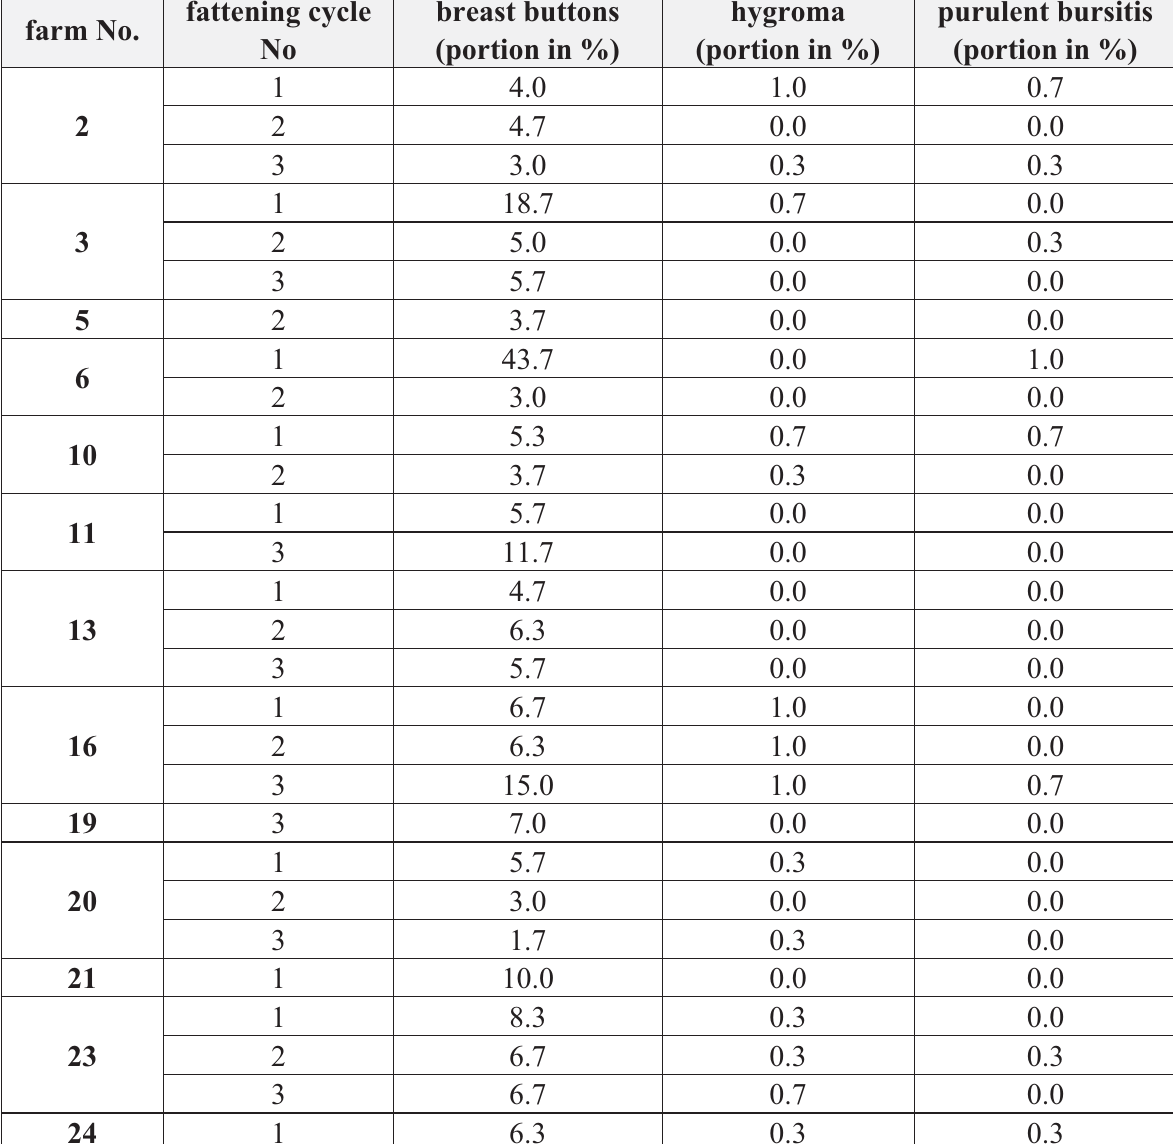
Table 3. Prevalence of breast skin alterations in female turkeys in meat examination. Individual value depiction arranged according to farms. farm